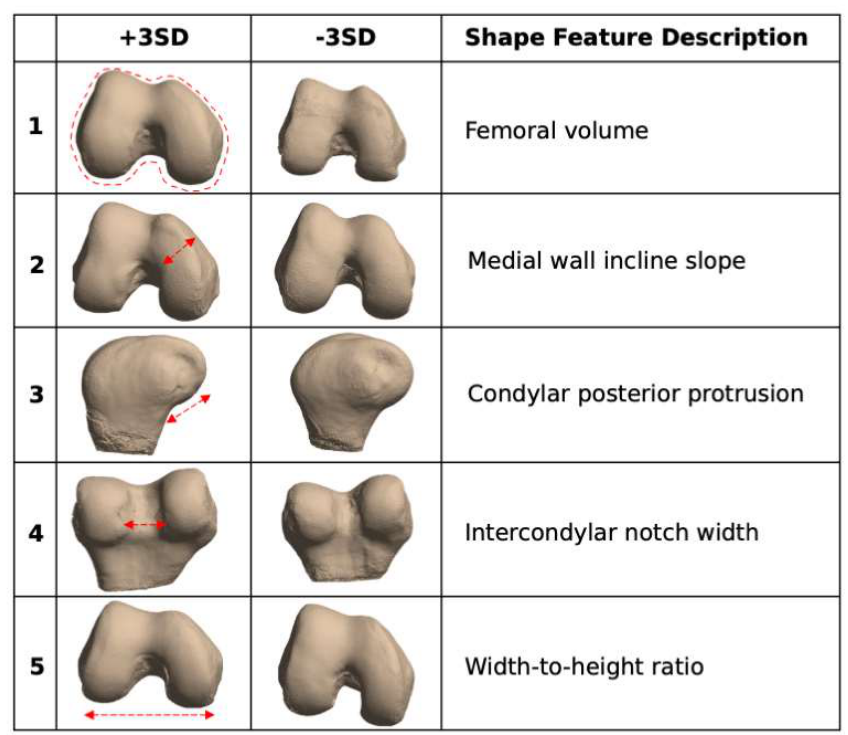
Figure 11. Femoral bone shape features, visualized after statistical parametrization, with qualitative descriptions of shape features. Similar features were also generated for the tibia and patella by the same procedure: extracting Euclidean points of bone surfaces, converting them into 1D vectors, using PCA to compress the resulting matrix into a 5-dimensional one, and visualizing each of the PCs.